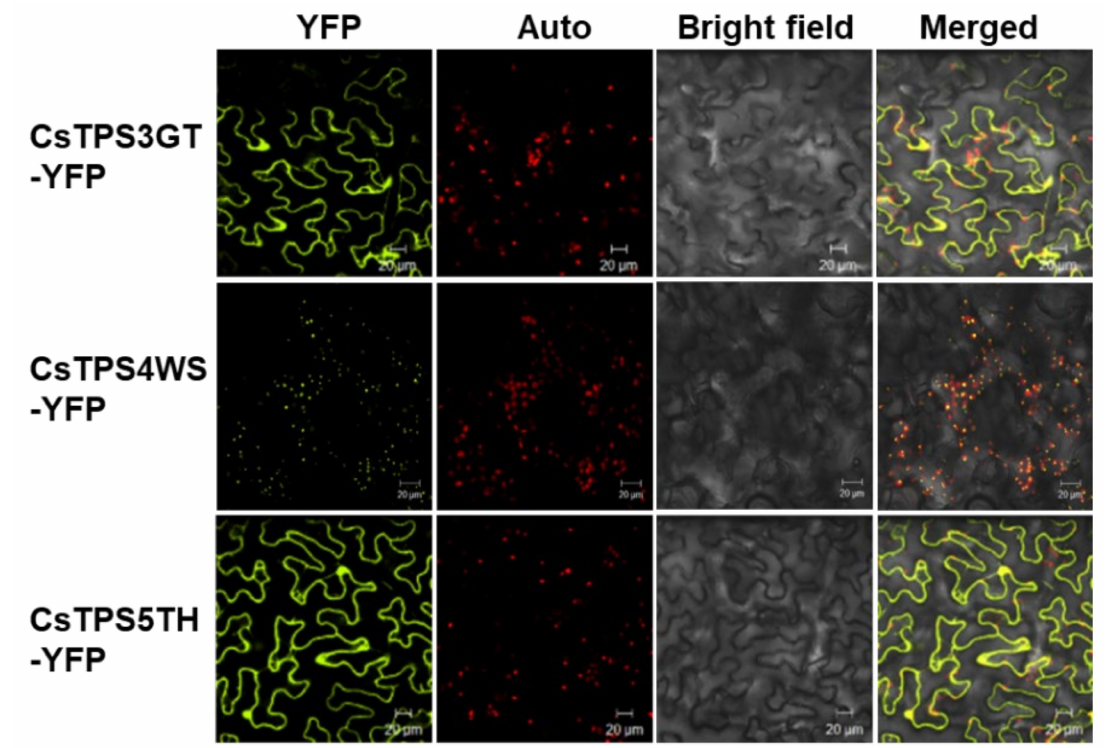
Figure 6. Subcellular localization of CsTPSs in N. benthamiana leaf cells. A. tumefaciens harbouring YFP-tagged CsTPS was infiltrated into N. benthamiana leaves. Then, the infiltrated leaves were visualized using a confocal microscope (2 dpi). Auto: chlorophyll autofluorescence; YFP: YFP channel image; Bright field: light microscope image; Merge: merged image between autofluorescence, YFP, and light channel. Scale bars: 20 µ